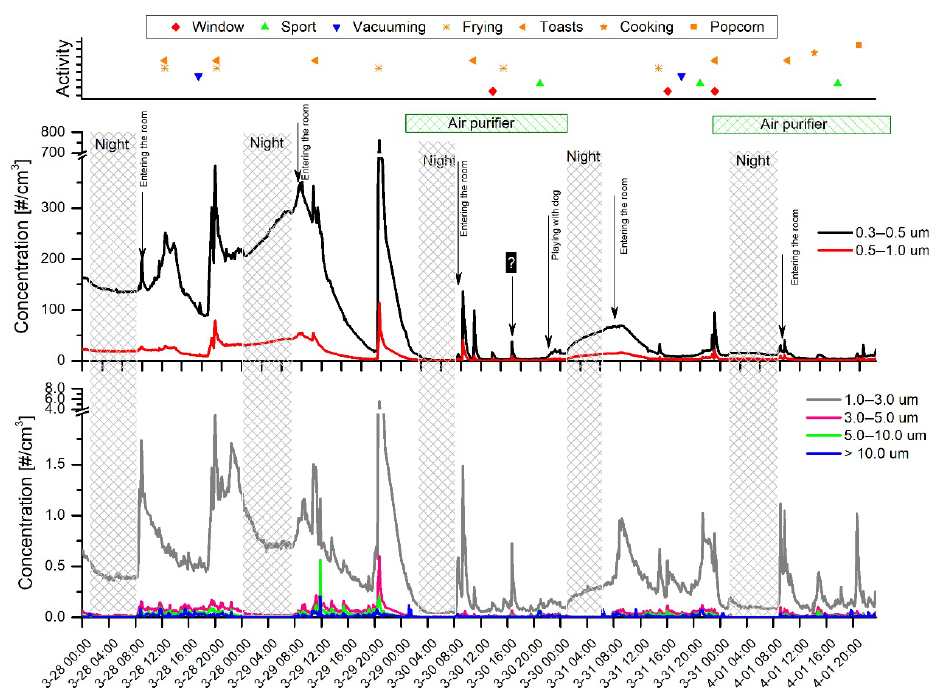
Figure 2. Time series of particle number (PN) concentrations recorded with the AeroTrak 8220 (TSI). The horizontal green bars represent the periods of air purifier usage in the room.